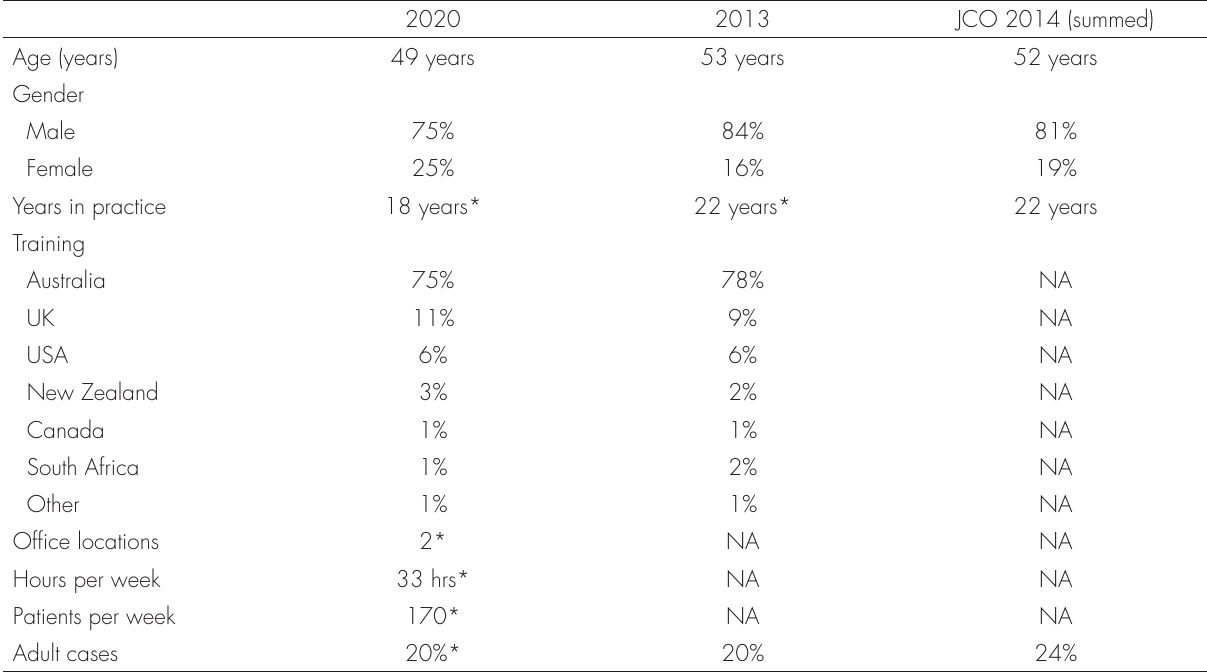
Table II. Demographics (medians).